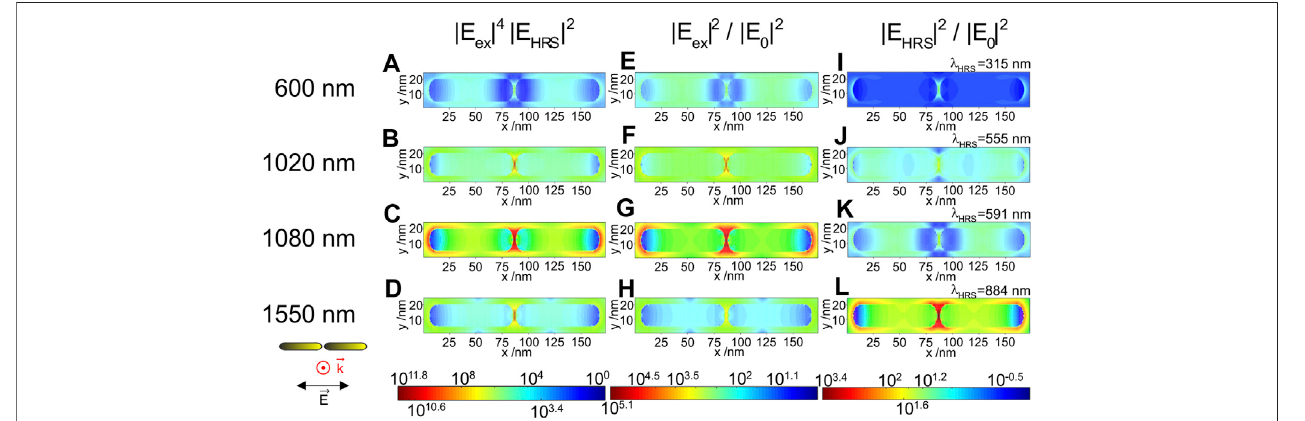
FIGURE 4 | (A – D) SEHRS enhancement of a gold nanorod dimer and corresponding normalized fi eld intensities at (E,F) excitation wavelengths, and at (I – L) StokesHRSwavelengthsinthex,y-planeasresultof3DFDTDsimulations.Thelengthoftherodsis80 nmandtheirthicknessis16 nm.Thegapbetweentheparticlesis 2 nm.Thepropagationandpolarizationoftheincidentplanewaveareindicated.Themonitorisplacedintheequatorialplane.ThewavelengthoftheHRSforeachofthe excitation wavelengths corresponds to a molecular vibration with a wavenumber of 1,586 cm − 1 and is indicated in each of the panels (I) to (L) . The maximum SEHRS enhancement of 10 11.8 is found for an excitation wavelength of 1,080 nm (C) . The highest excitation intensity enhancement, also observed at 1,080 nm has a value of 10 5.1 (G) . The maximum HRS intensity enhancement of 10 3.4 is obtained for a Stokes HRS wavelength of 884 nm, upon excitation at 1,550 nm (L)